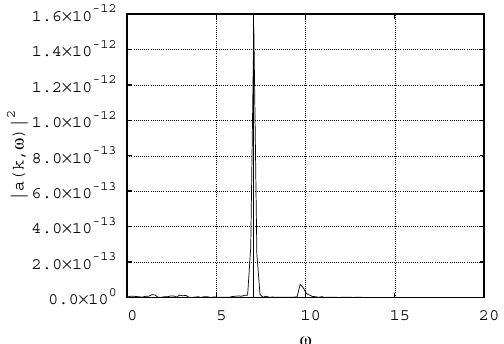
Figure 12. Spectral line of the harmonic k = (0, 150). Only the con- densate was